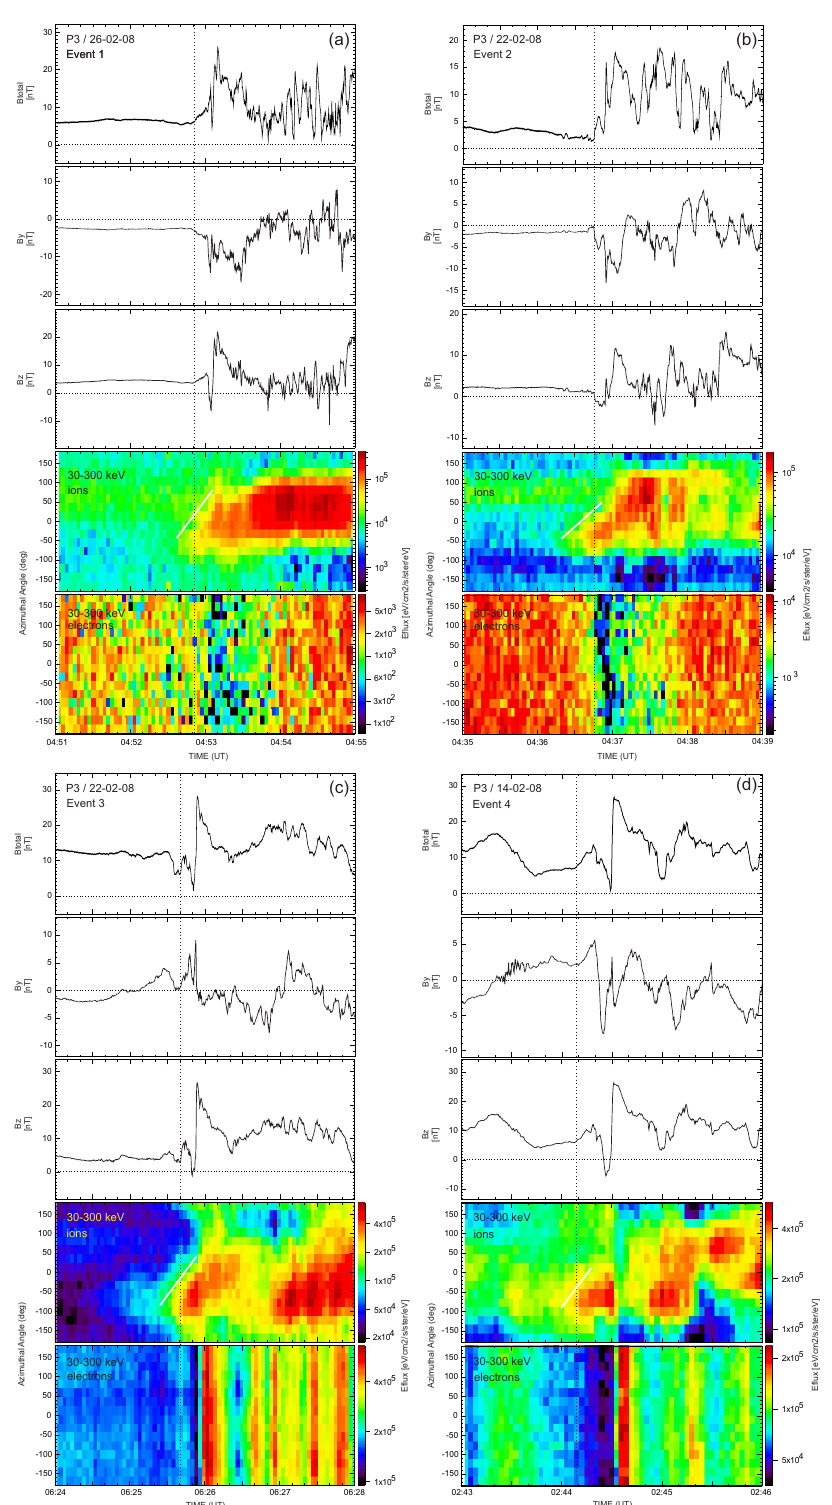
Fig. 6. Time-zoomed plots of all four individual dipolarization front events. Each plot consists of five panels. Magnetic field intensity, B y , and B z magnetic field components in GSM coordinates are plotted in the first three panels of each plot with a 0.25s time resolution. The fourth and fifth panels of each plot present ion and electron differential energy fluxes versus azimuthal angle in the probe rotation plane, measured by the SST instrument in the 30–300keV energy range. Zero degrees correspond to earthward fluxes. Note that in B total panels zero level is shifted for